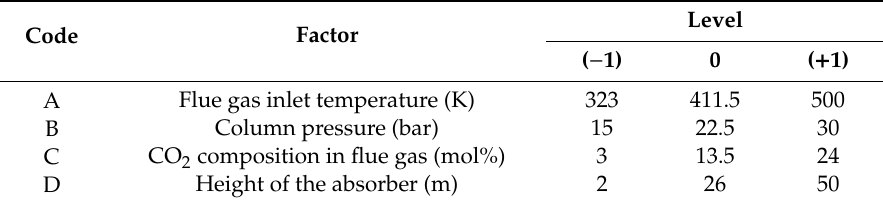
Table 6. Values of each level for each factor in the FCCCD